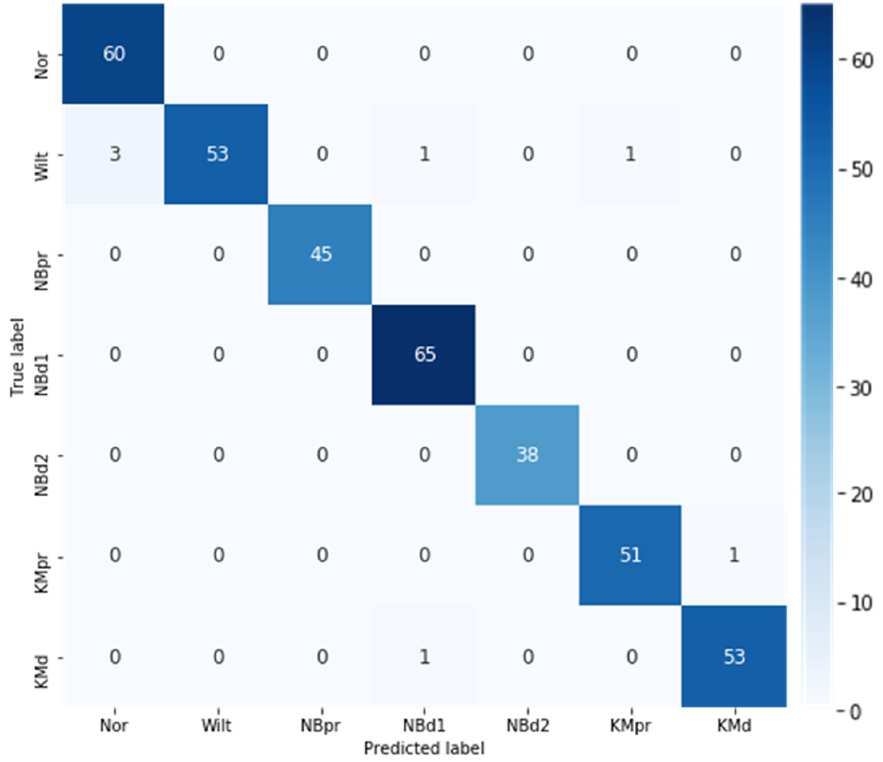
Figure 12. Test set confusion matrix for the Adam optimizer model. Table 3. Performance evaluation index according to plant physiological disorders.